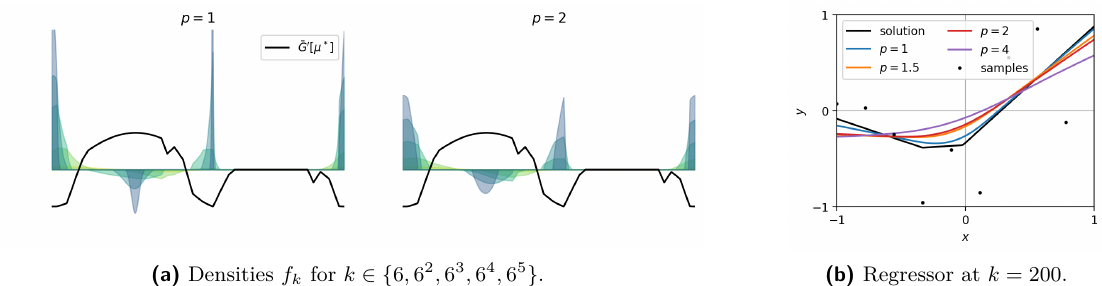
Figure 9 Dynamics of PGM on a two-layer neural network, for various values of p ( p = 1 corresponds to η hyp ). Observe in (b) how the dynamics with η hyp fits the kinks of the optimal regressor much faster than with p >